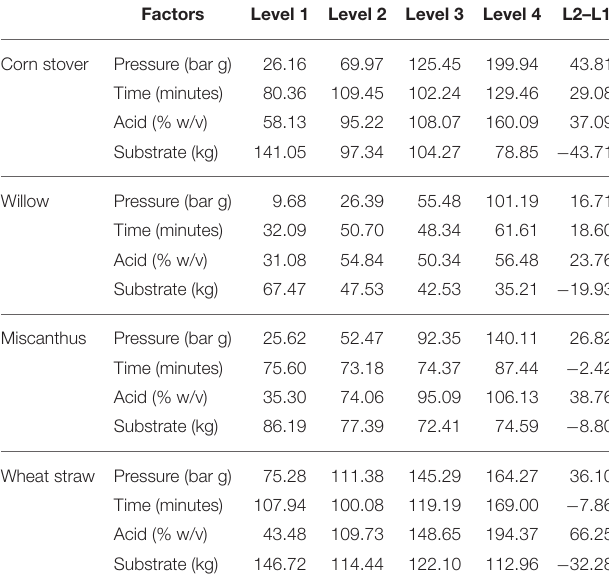
TABLE 2 | Compositional analysis of raw feedstock as a percentage of total dry matter (DM) n = 3. Willow Corn stover Miscanthus Wheat straw